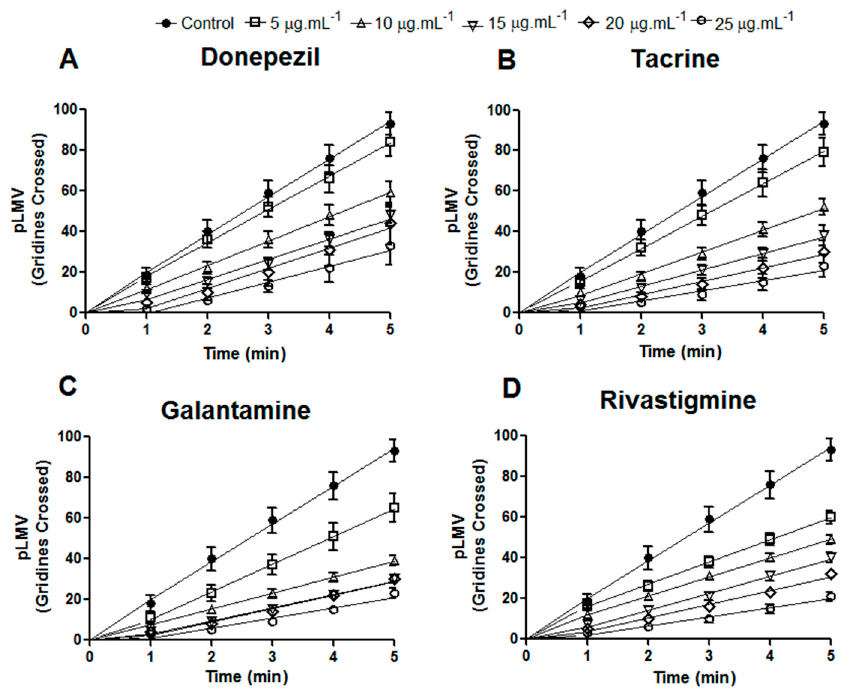
Figure 3. Effects of donepezil ( A ) tacrine ( B ); rivastigmine ( C ) and galantamine ( D ) on motility (planarian locomotor velocity (pLMV)) in Dugesia tigrina , after 5 min of exposure. Samples were tested in triplicate with 30 planarians in each Petri dish.